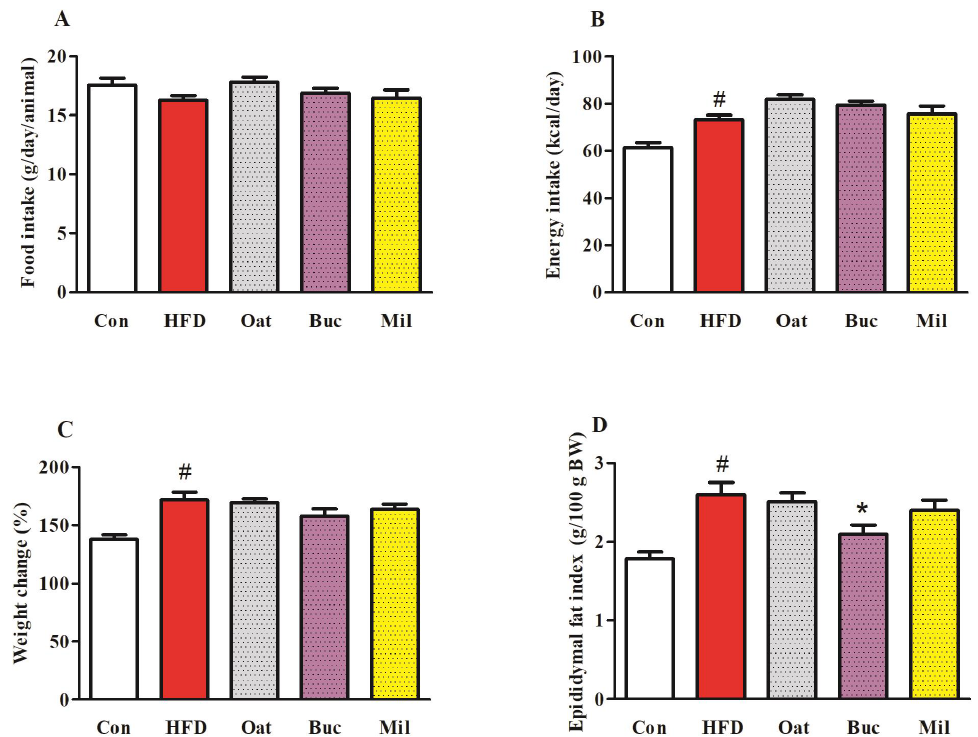
Figure 1. Effect of oats, tartary buckwheat, and foxtail millet supplementation on food intake ( A ), energy intake ( B ), percent change in body weight ( C ), and epididymal fat index ( D ) in high-fat diet fed rats. Con group, a basal diet group; HFD group, a high-fat diet group; Oat group, HFD containing 22% oat group; Buc group, HFD containing 22% tartary buckwheat group; Mil group, HFD containing 22% foxtail millet group. Data are presented as the mean ± SD ( n = 12). # p < 0.05, compared to Con group, * p < 0.05, compared to HFD